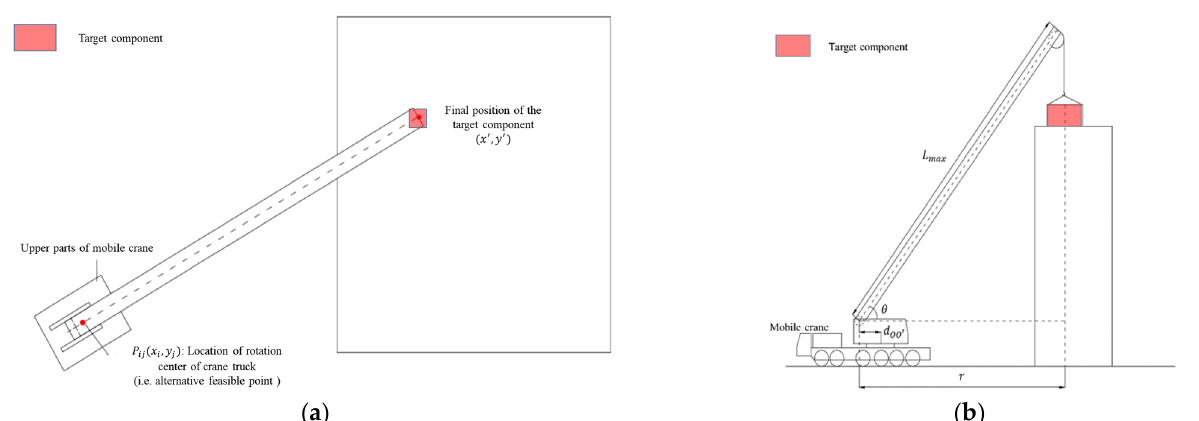
Figure 3. Operation constraint check.